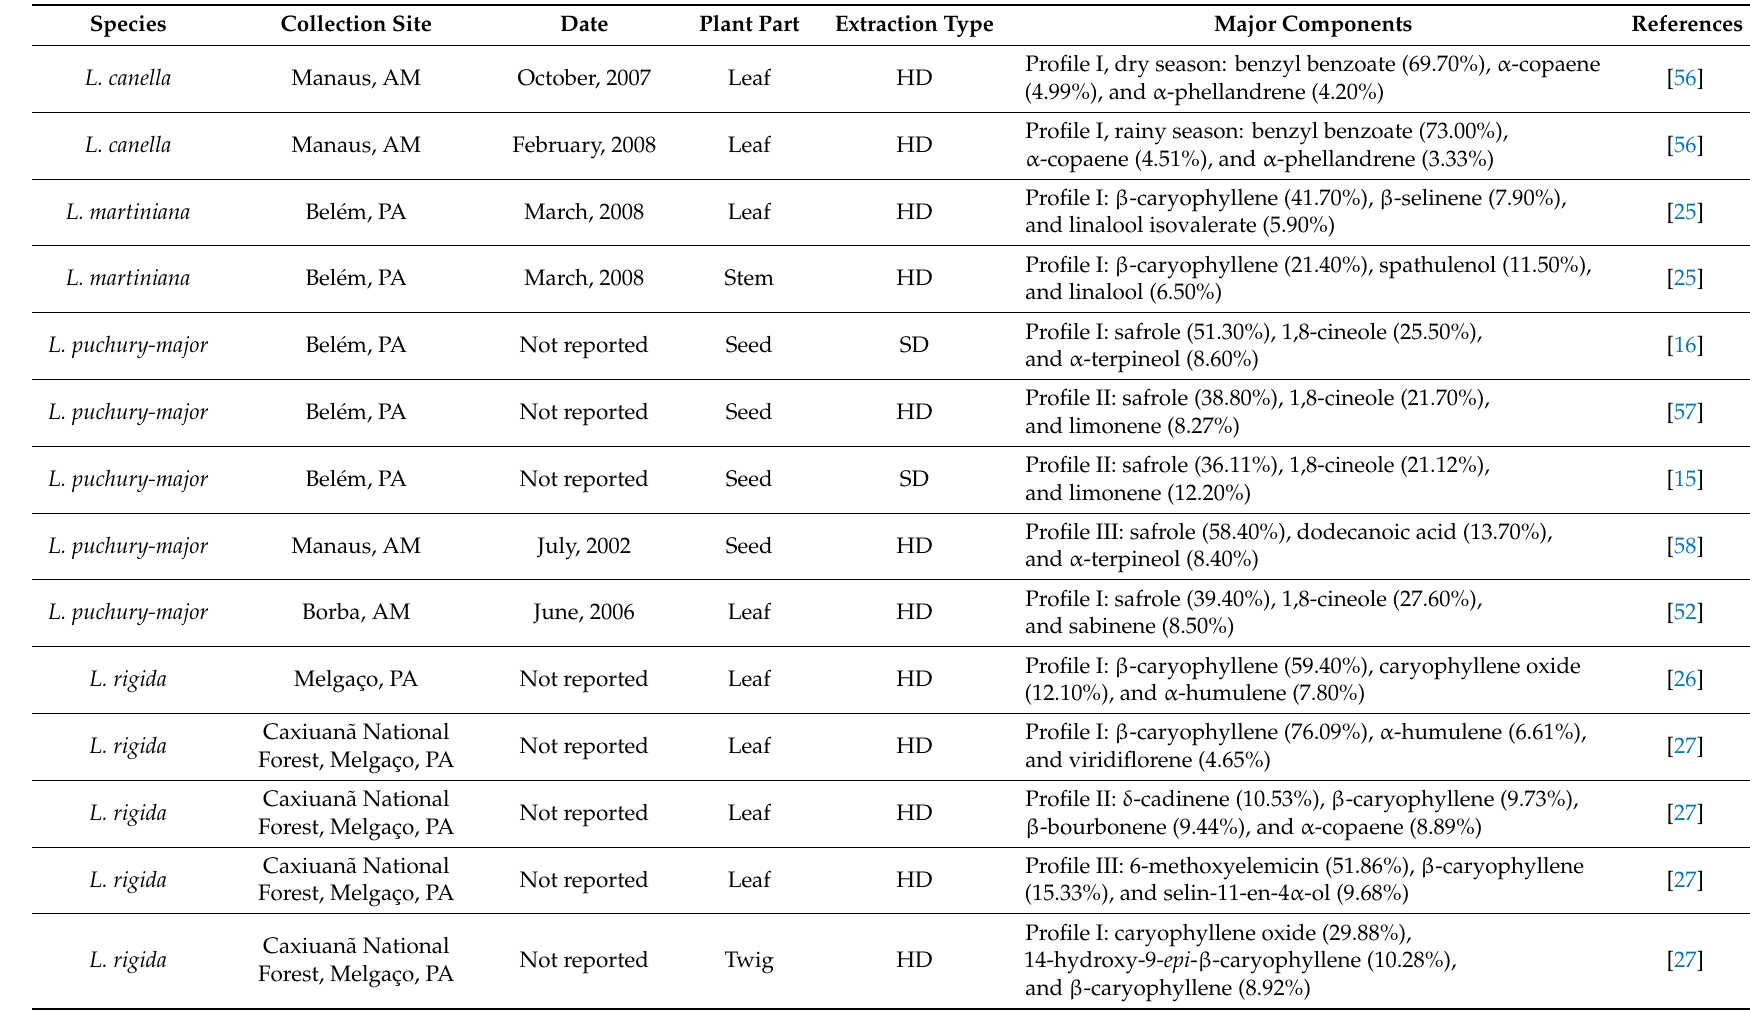
Table 1. Essential oil compositions of Ocotea, Nectandra and Licaria species from